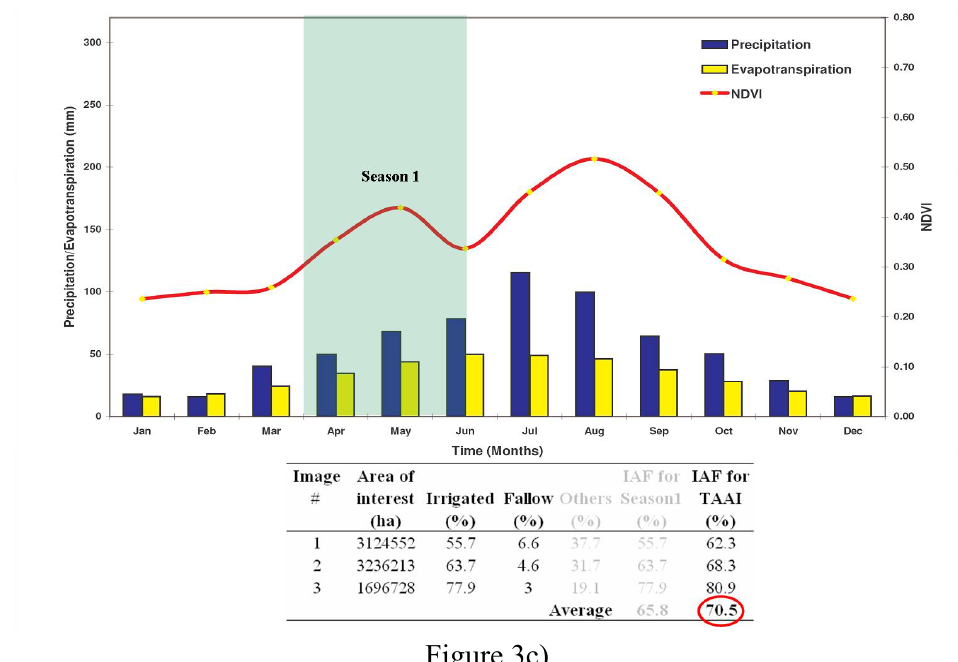
Figure 3. Irrigated area fraction from high resolution imagery (IAF-HRI). The process of IAF-HRI determination using Landsat 30m data taking images of season 1 (Figure 3b) and season 2 (Figure